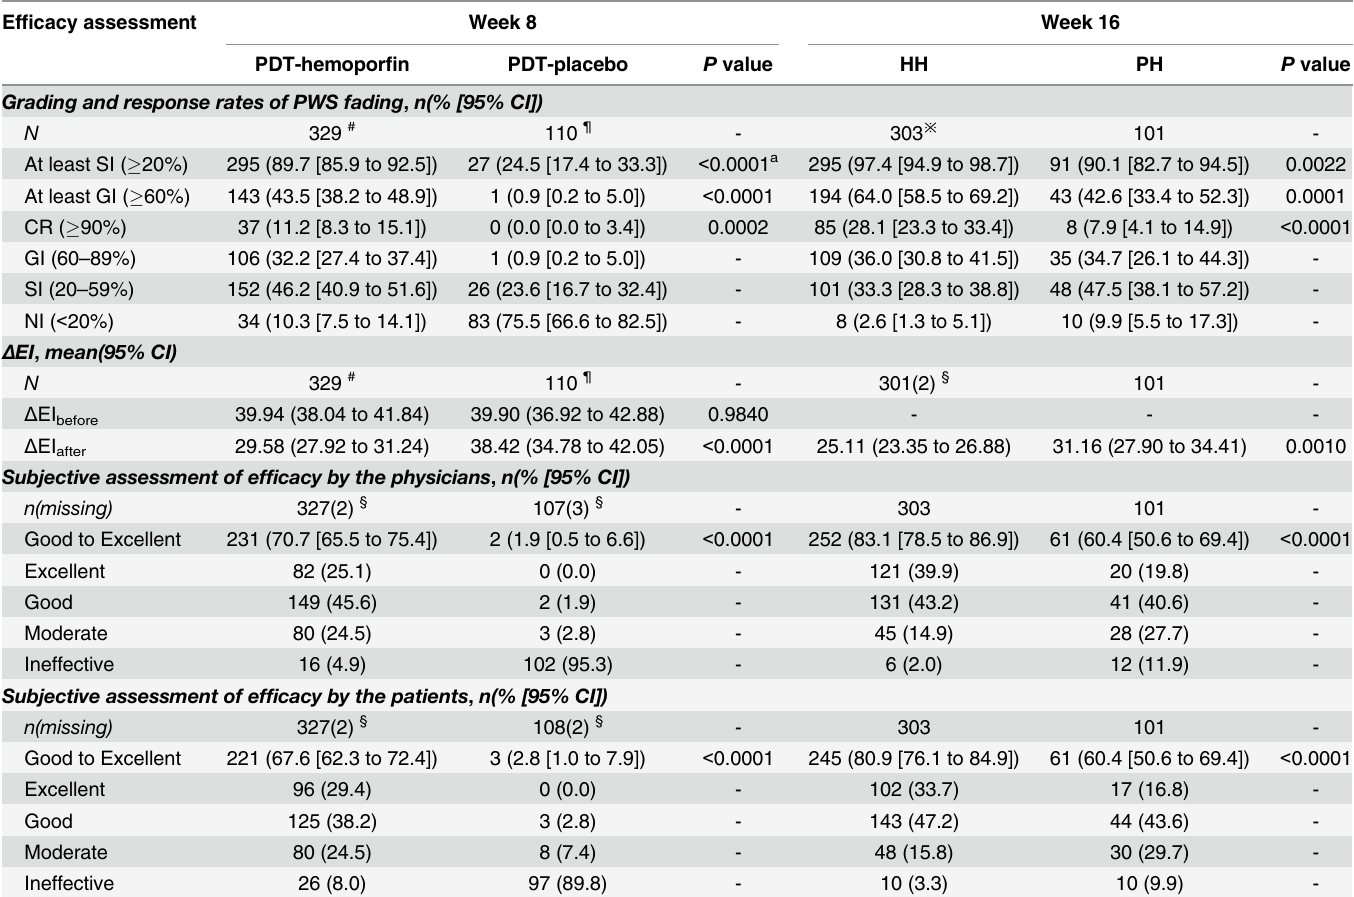
Table 2. Efficacy assessment at week 8 and